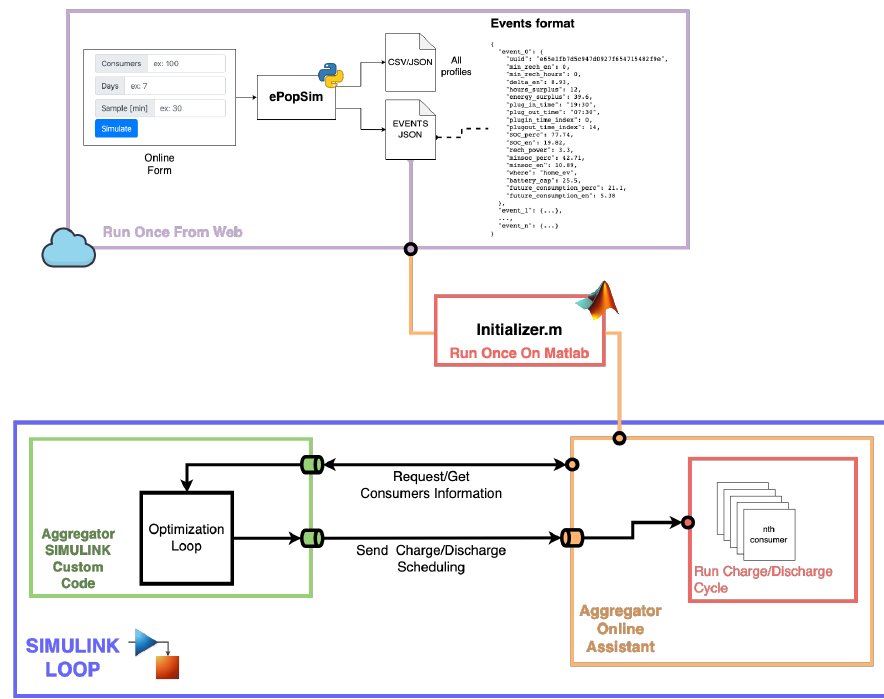
Figure 1. Graphical representation of the currently implemented architecture of the presented software. The top frame represents the cloud-accessible software to operate an aggregator-less simulation. Simulated customer requirements and habits are then downloaded and fed to the offline Simulink block through an Initializer.m script. The bottom frame represents the customizable offline Simulink-based simulator. The orange box, or Aggregator Online Assistant (AOA), explained in detail in the following sections, is in charge of applying the recharging rules imposed by the green box (custom aggregator logic), following the simulated habits and requirement constraints of the EV owners simulated in the online